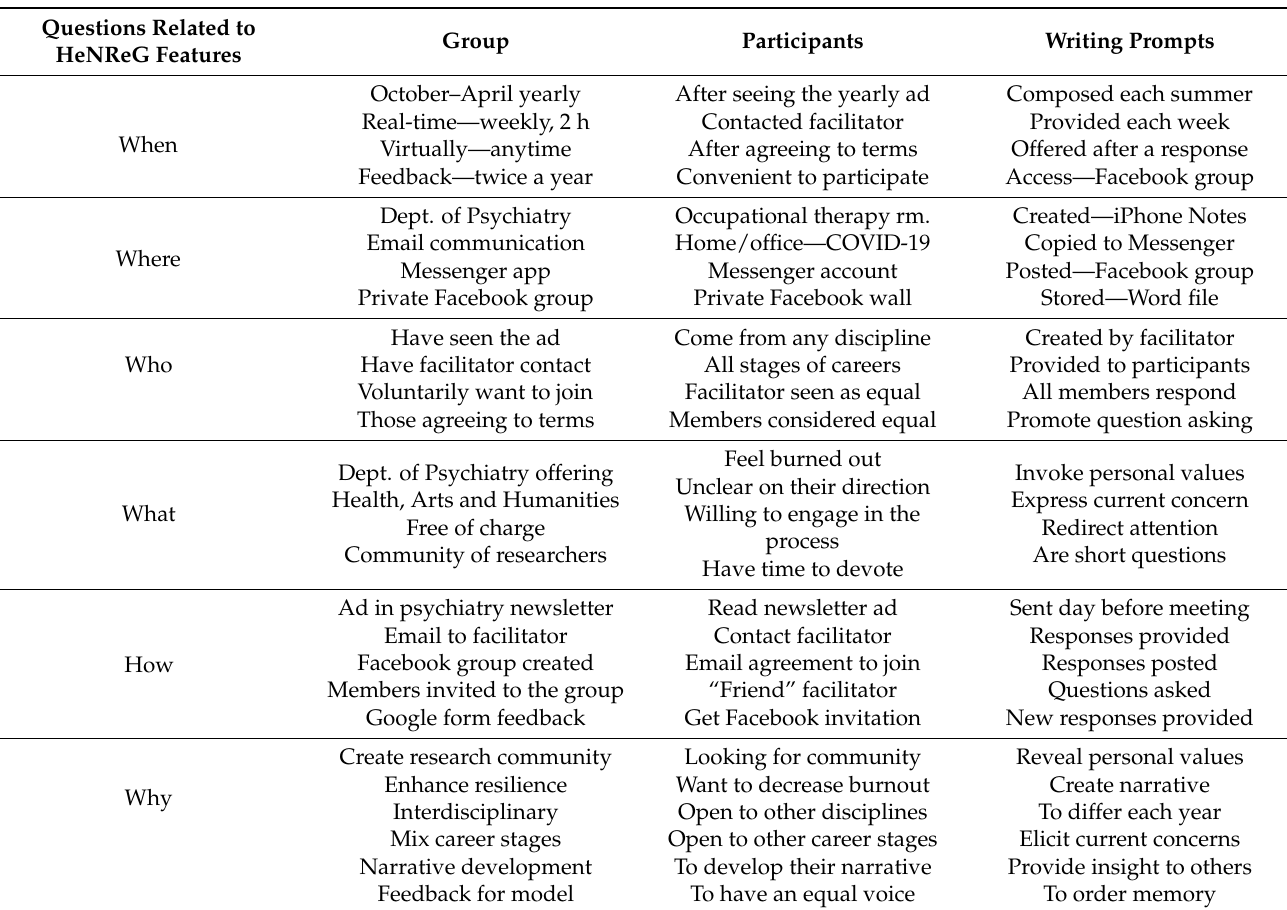
Table 1. Features of the three aspects of the Health Narratives Research Group (HeNReG) arranged in relation to the HeNReG process with respect to the type and order of the six different questions of writing prompts